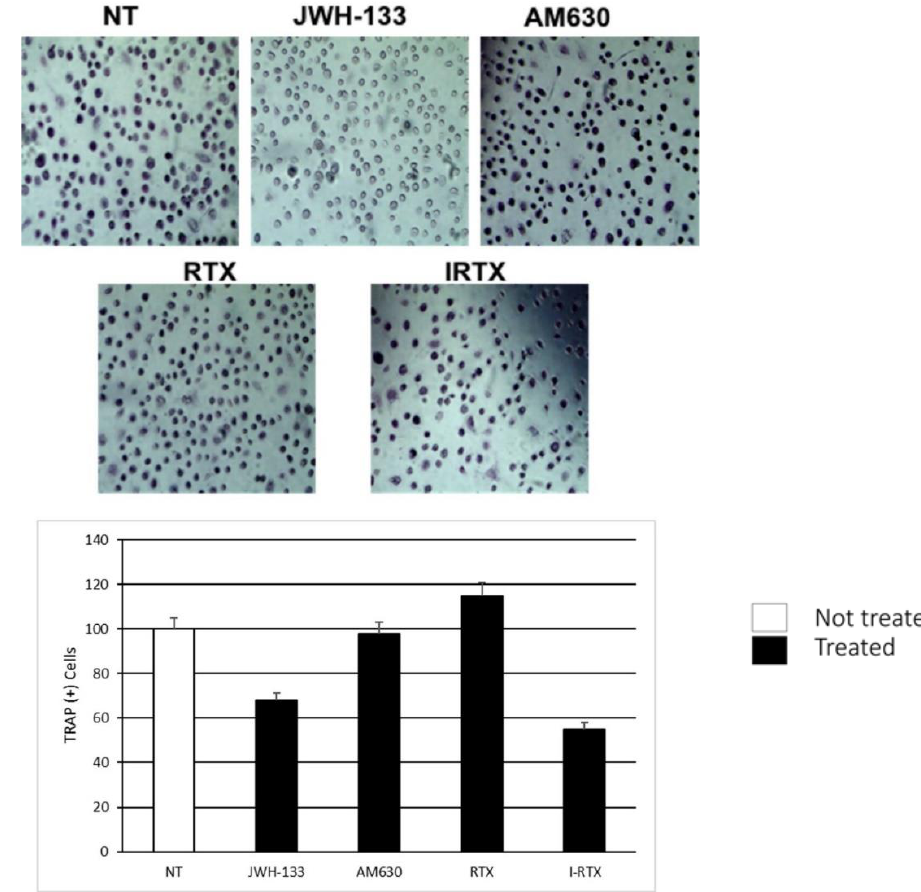
Figure 6. Comparison of the TRAP assay, performed on 2 OCs of patients with PBD, in the untreated (NT), JWH-133 AM630, RTX and IRTX treated samples. The most representative images are displayed. The percentage number of TRAP (+) cells with respect to the total cells number for each sample is presented in the histogram as mean ± SD.